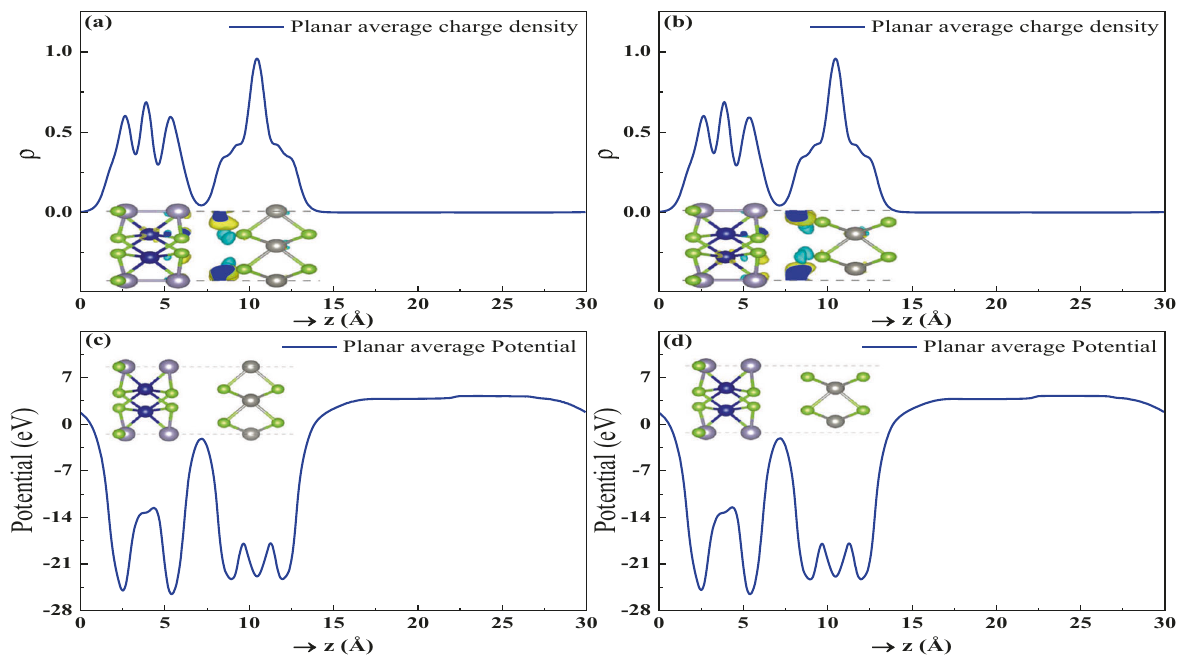
Fig. 4 Charge density and electrostatic potential. Planar average charge density along the z-direction for a S-1 stacked structure and b S-2 stacked structure. Insets are the charge density differences with isosurface value of ±0.0005 e Å − 3 . The average electrostatic potential along the z-direction in c S-1 and d S-2 stacked hetero